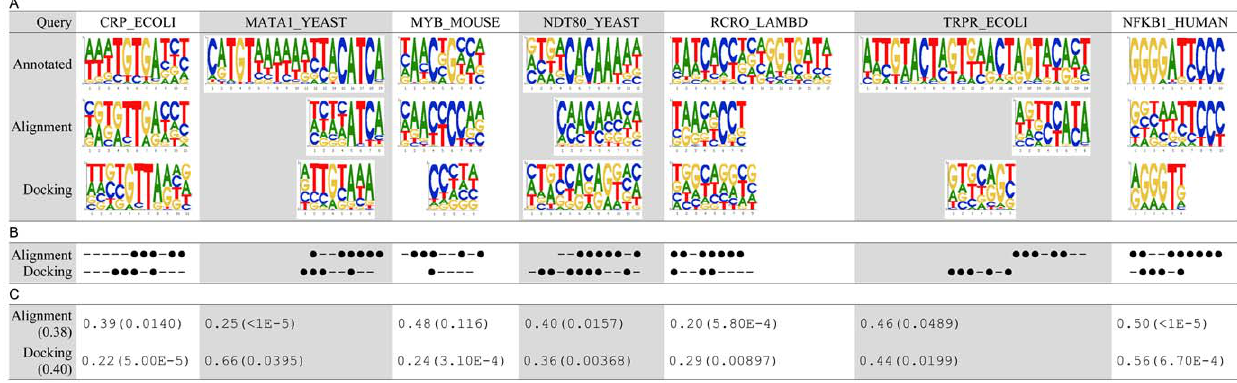
Figure 4. Comparison with predictions of using docking to construct synthetic complexes. The predictions based on the proposed alignment-based approach to construct synthetic complexes are denoted as ‘Alignment’, while those of ZDOCK are denoted as ‘Docking’. (A) PWMs. N ’ if its most favorable base type was correctly predicted, or marked as ‘–’ otherwise. (C) Y -scores and the corresponding (B) A position is marked as ‘ p-values. The value within the parentheses of the first column indicates the average Y -score. doi:10.1371/journal.pone.0030446.g004 PLoS ONE |